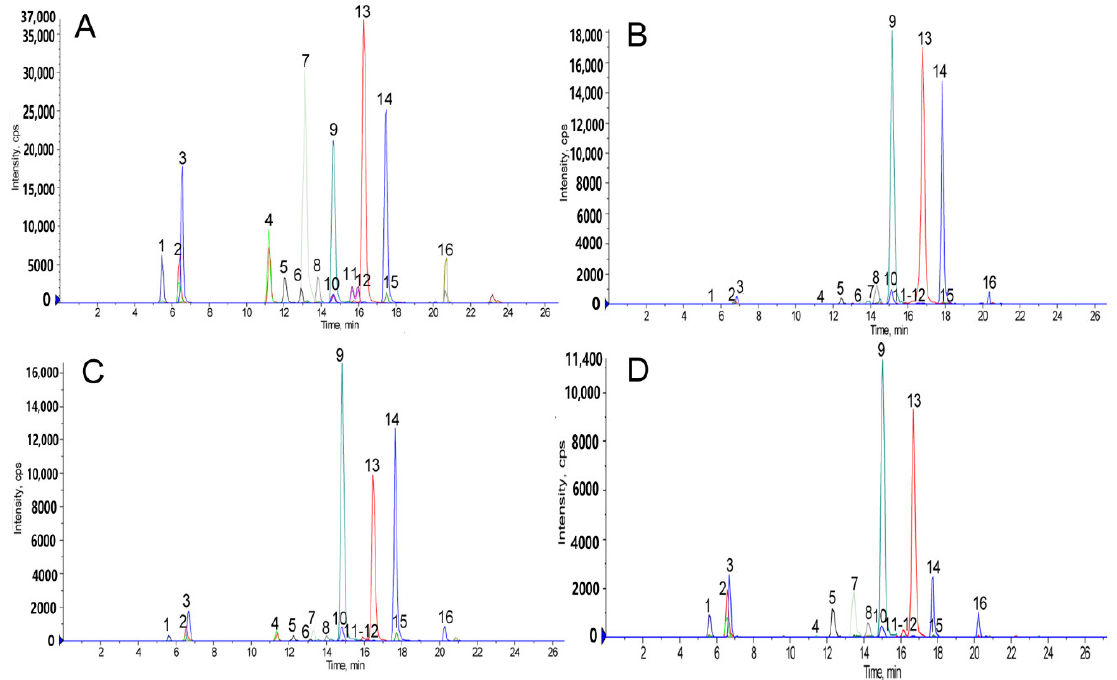
Figure 4. The total ion MRM chromatograms of the reference standards ( A ) and the roots and rhizomes of Panax japonicas ( B ), Panax japonicus var. major ( C ), and Panax zingiberensis ( D ) obtained in negative mode by HPLC-ESI-MS/MS.